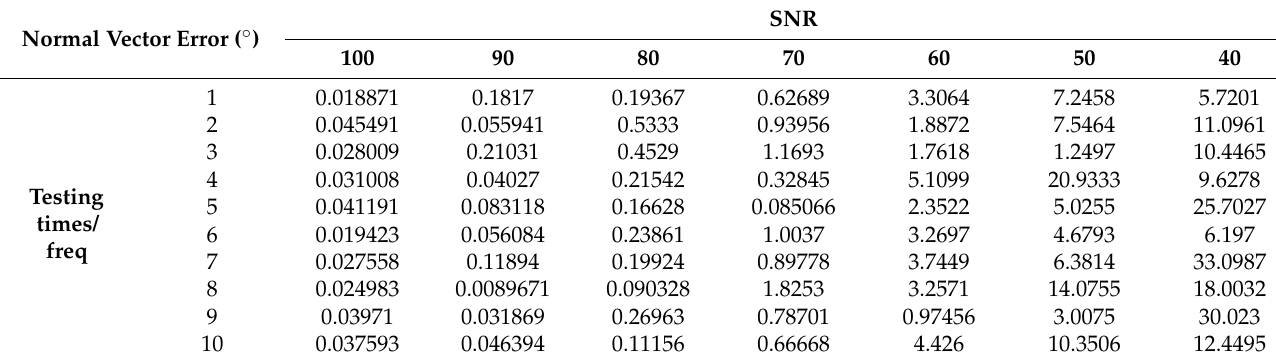
Table 5. Target normal error results of image elliptical edge points with noise.